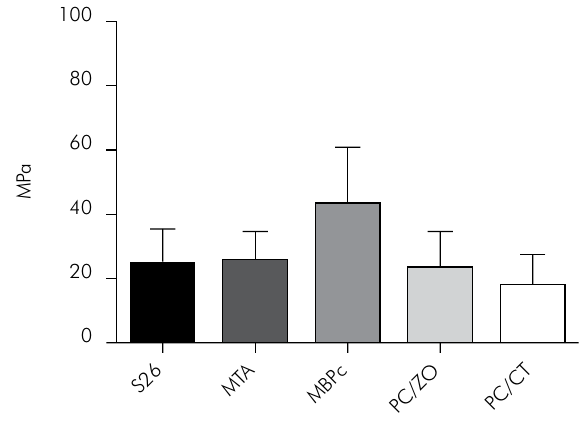
Figure 1. Graphical representation of the mean and standard deviation of the push-out strength